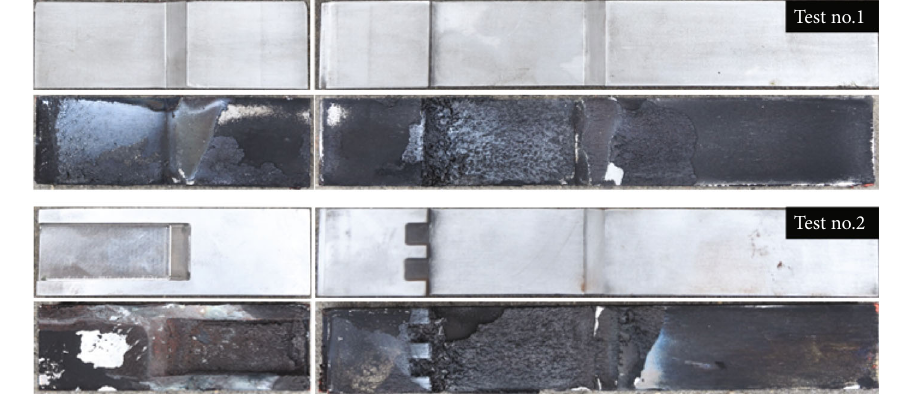
Figure 12: Schematic of the cavity structural changes before and after the